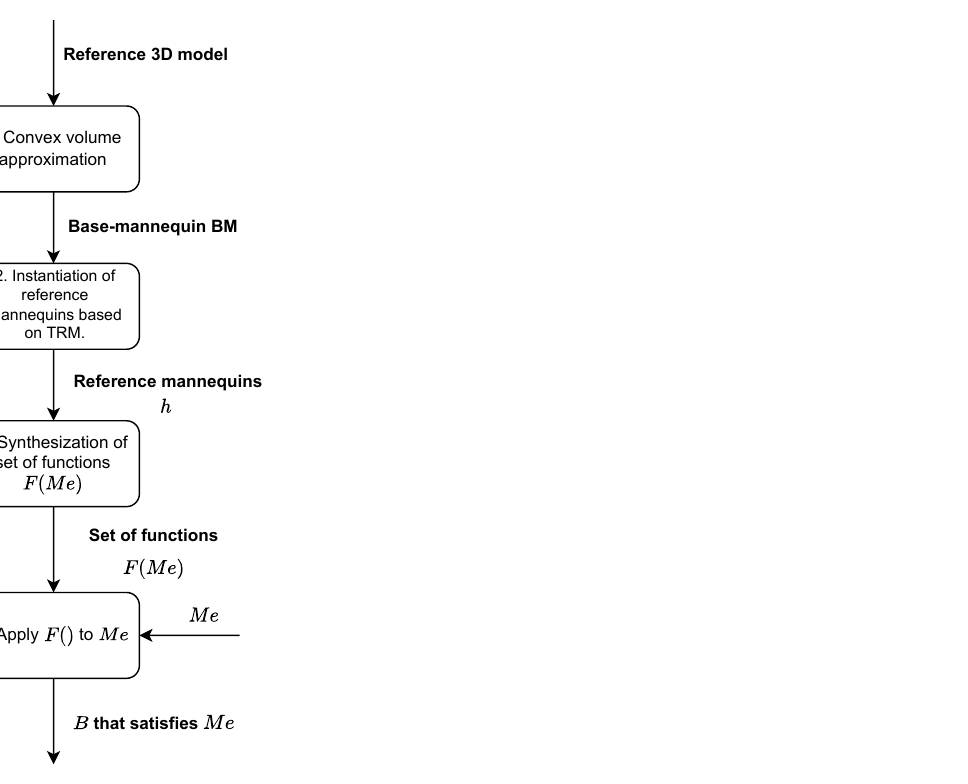
Figure 1. Flow diagram of the convex-volume-based measurement-driven approximation. Input: Reference 3D model. Output: Measurement-driven mannequin B . Steps 1 and 2 pre-processing. Steps 3 and 4 are